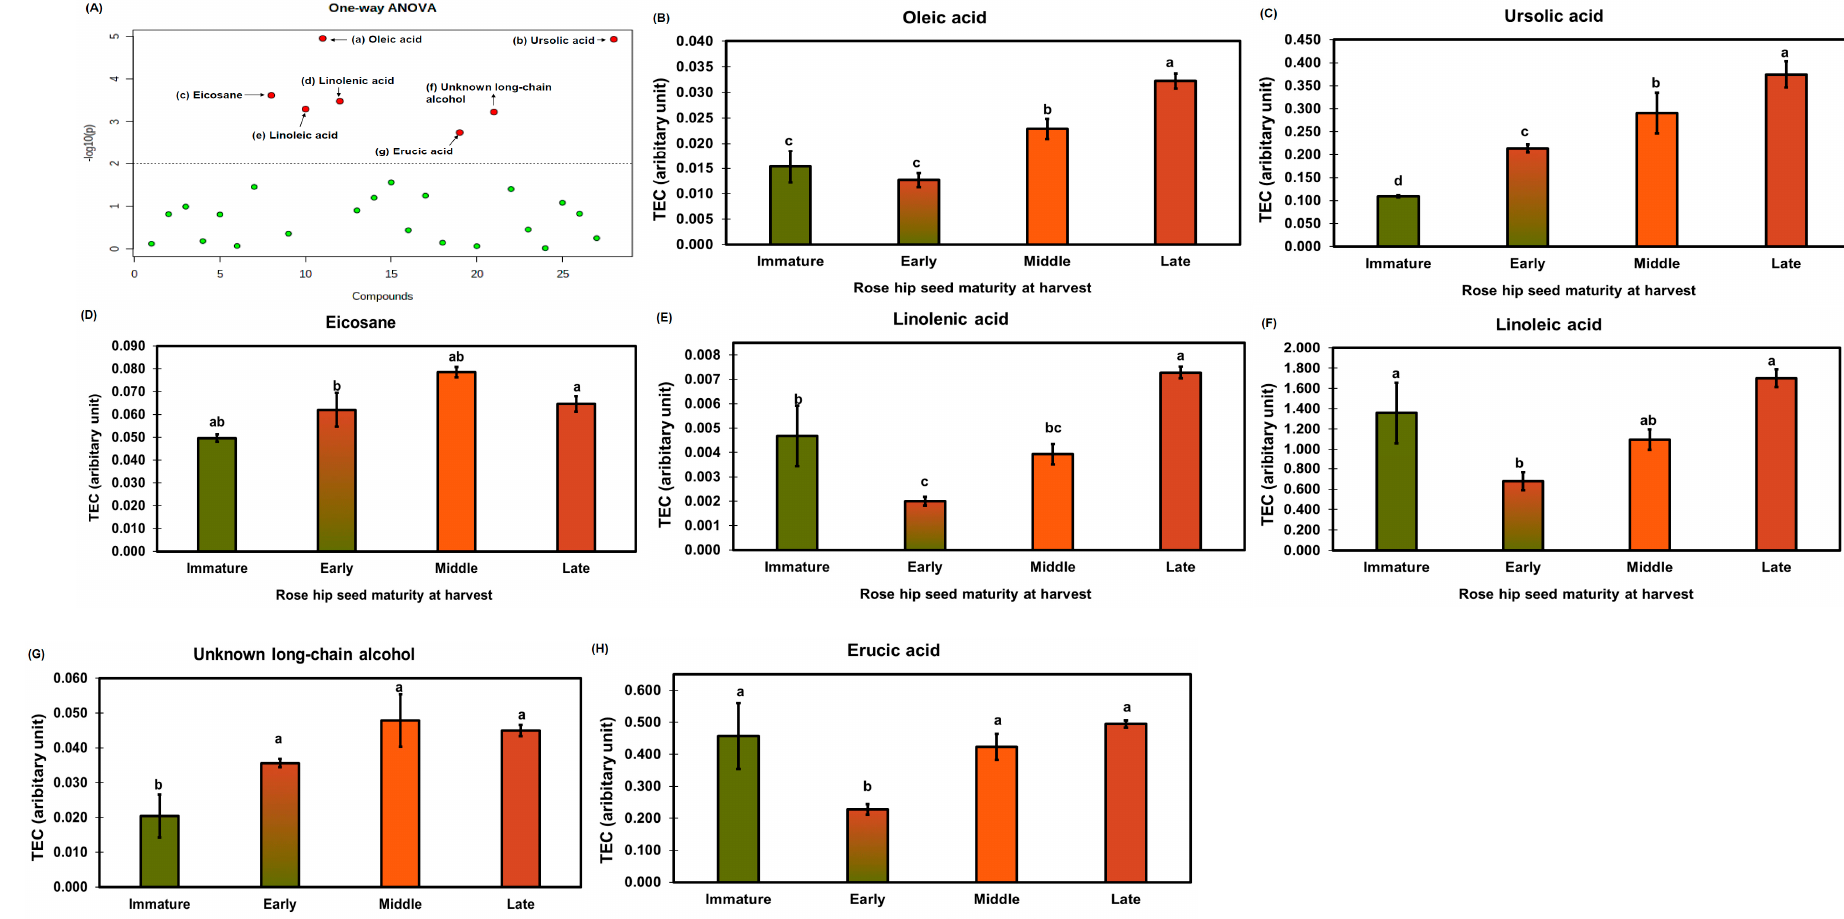
Figure 8. Red dots in the one-way ANOVA ( A ) indicate significantly different lipid-soluble metabolites among different rose hip maturities ( p < 0.01). The specific concentrations of the lipid-soluble metabolites from rose hip seed ( B – H ) are expressed as a bar graph. TEC indicates tetracosane equivalent concentration based on an internal standard (tetracosane). The bars and error bars represent the mean ± standard deviation of three biological replications. Letters above bars represent significant differences among different rose hip maturities Tukey’s HSD test ( p < 0.05).